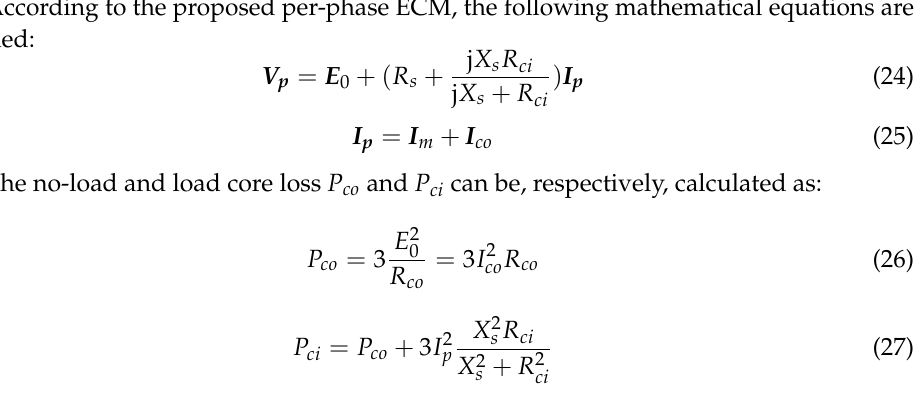
According to the proposed per-phase ECM, the following mathematical equations are